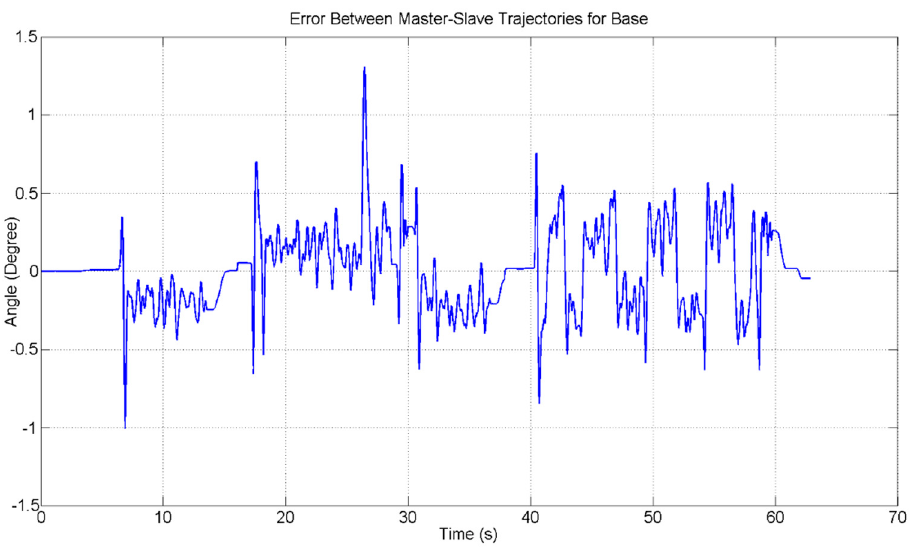
Figure 22. Error between master–slave trajectories for base.